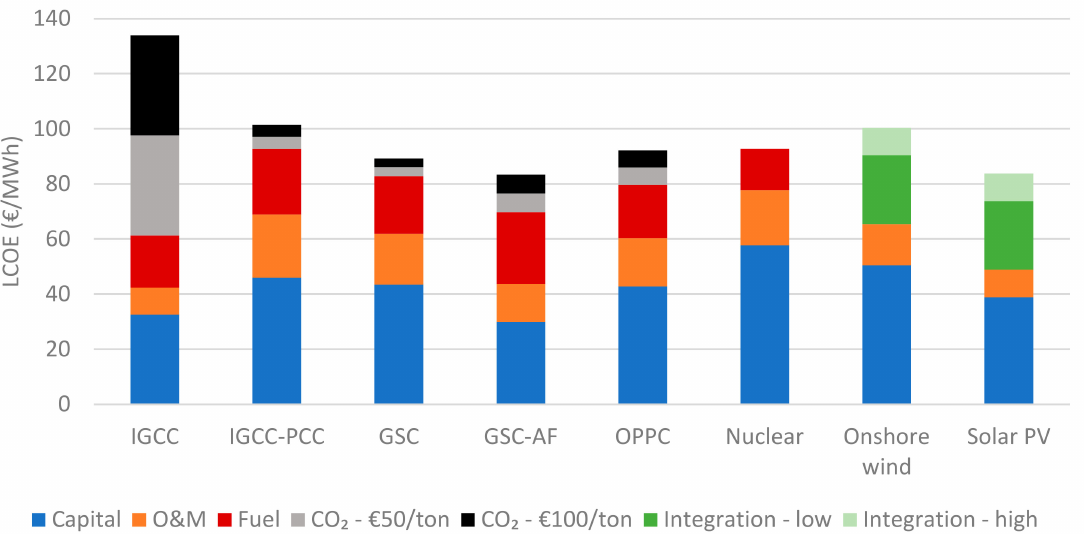
Figure 9. Benchmarking of the five IGCC-based power plants evaluated in this study against nuclear, wind, and solar power using costs relevant to the year 2040 when the CO 2 price is set to 50–100 €